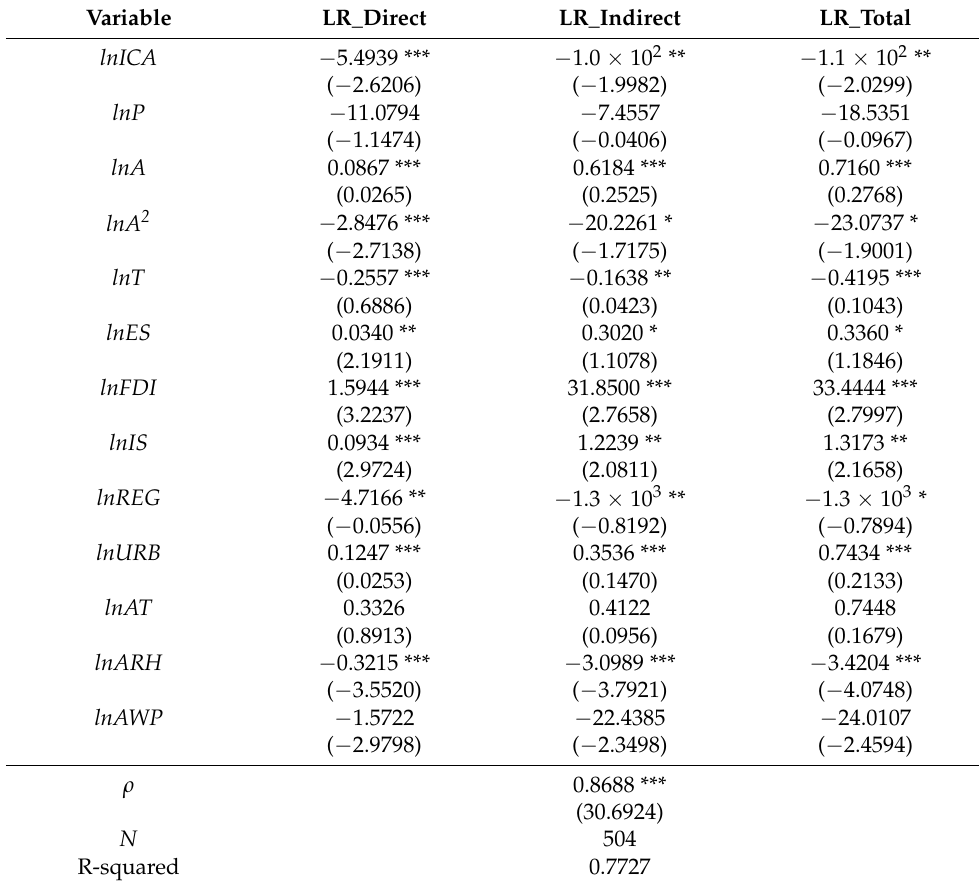
Table 5. Decomposition of effects in the dynamic SDM